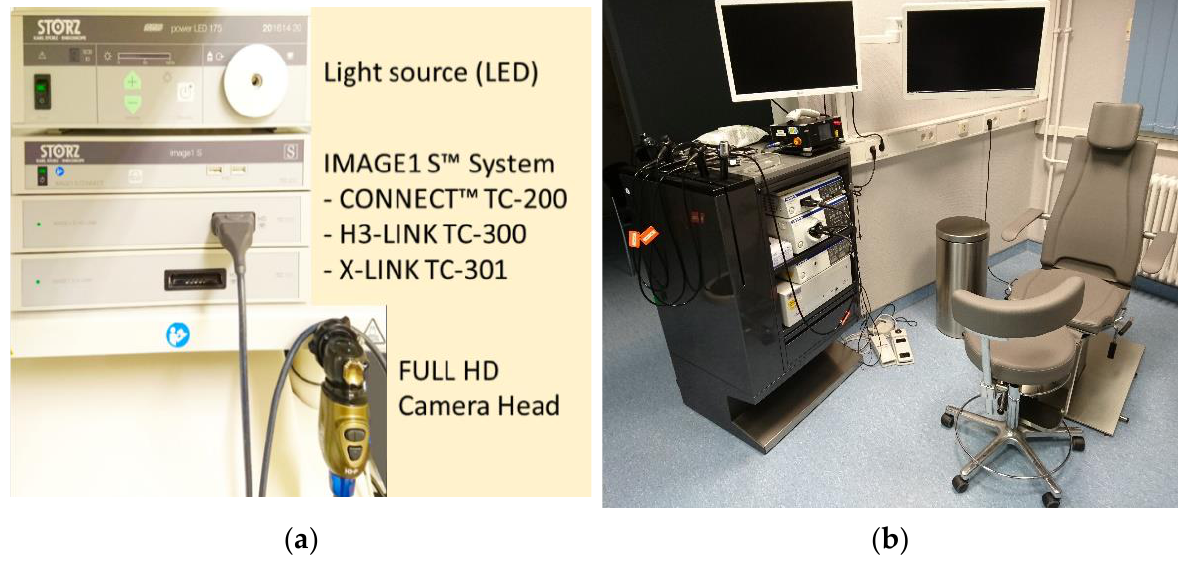
Figure 1. ( a ) Example of an endoscopic imaging system of KARL STORZ. The modular video processor IMAGE 1 allows the connection of various endoscopic devices. ( b ) Endoscopy workplace for ENT with OLYMPUS video processor, light sources and flexible endoscopes on the right.